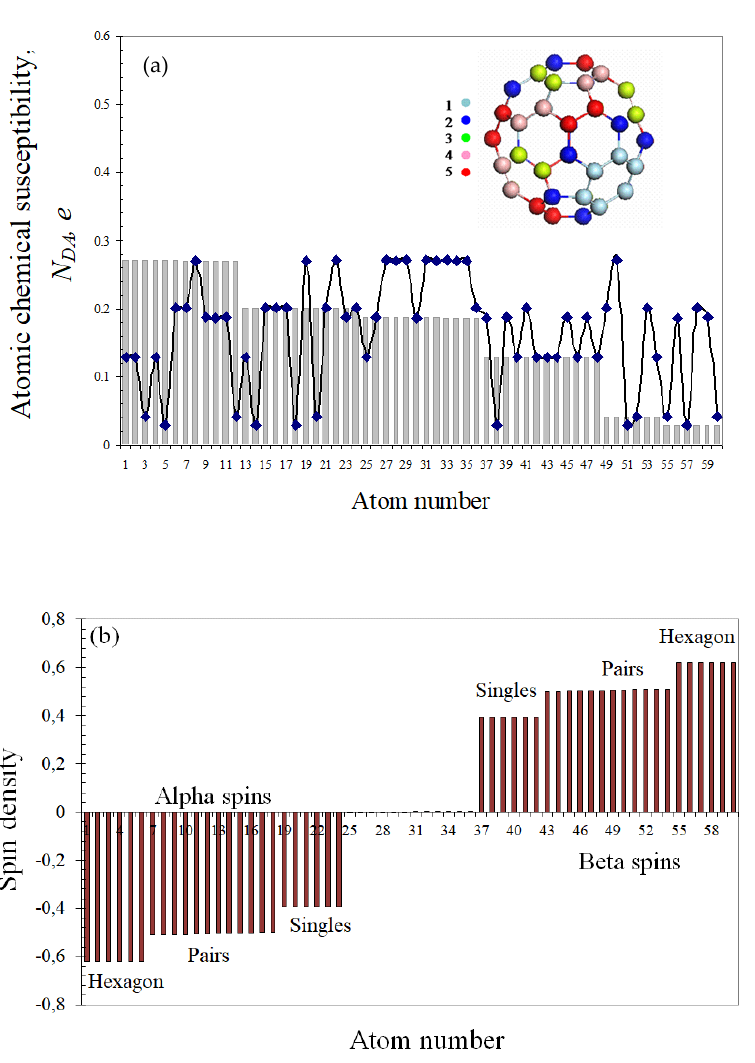
Figure 2. ( a ). Atomic chemical susceptibility N DA of fullerene C 60 , distributed over the molecule atoms according to either their numeration in the output file (curve with rhombs) or in the Z → A manner (histogram). Different colors in the insert on the right distinguish six atomic groups shown by the histogram. ( b ) Spin density distribution.